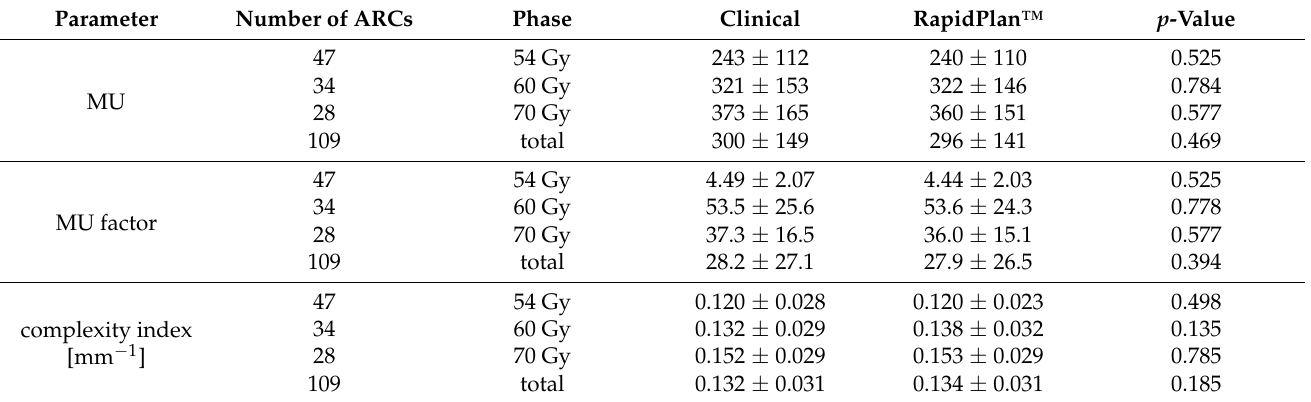
Table 5. Monitor units (MUs), modulation factor (MU factor), and the complexity index for clinical plans against RapidPlan™ plans in the open-loop validation